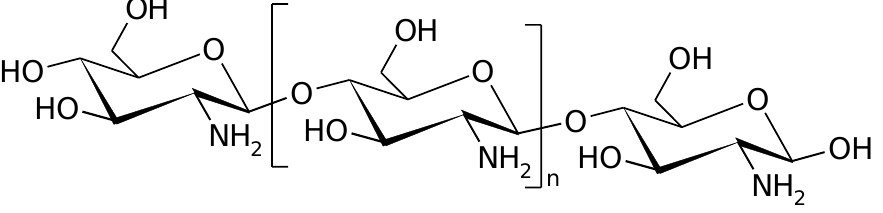
Figure 6. The fragment of chitosan